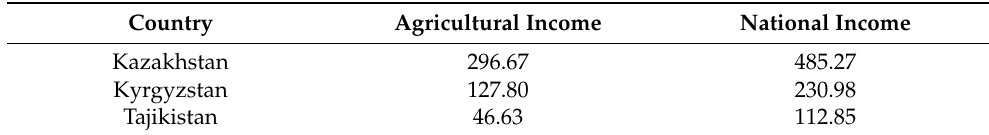
Table 5. Comparison between monthly per capita agricultural income and national income in Central Asia in 2020. (Unit: